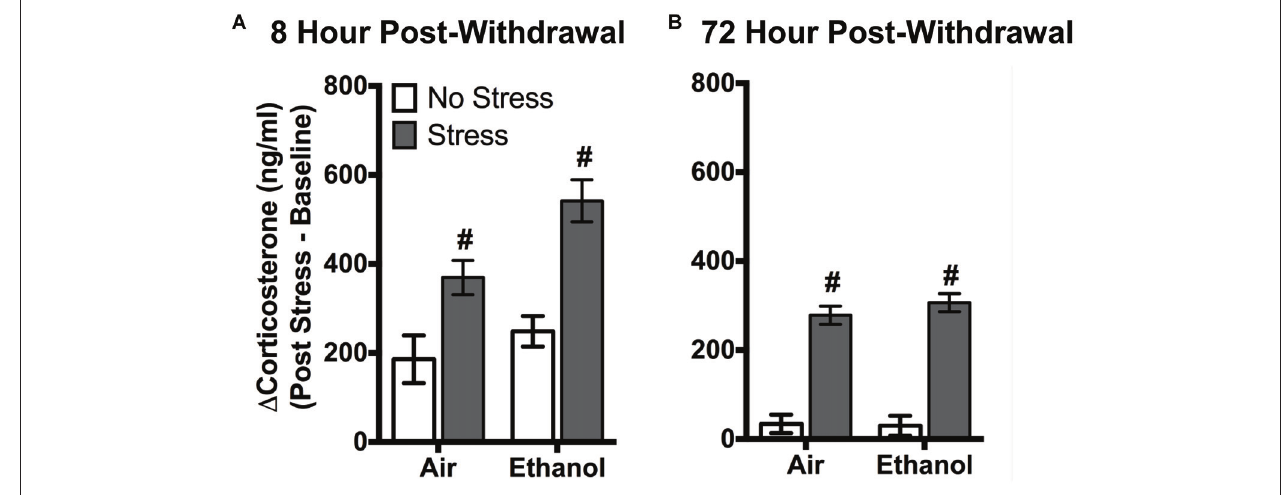
FIGURE 1 | Effects of chronic intermittent ethanol (CIE) or air exposure on circulating corticosterone (ng/ml) levels following (A) 8 h or (B) 72 h post-withdrawal in non-stressed (clear bars) or stressed mice (gray bars) . Data are depicted as mean difference between post-stress and baseline corticosterone levels ± SEM. # Indicates main effect of Stress ( p <